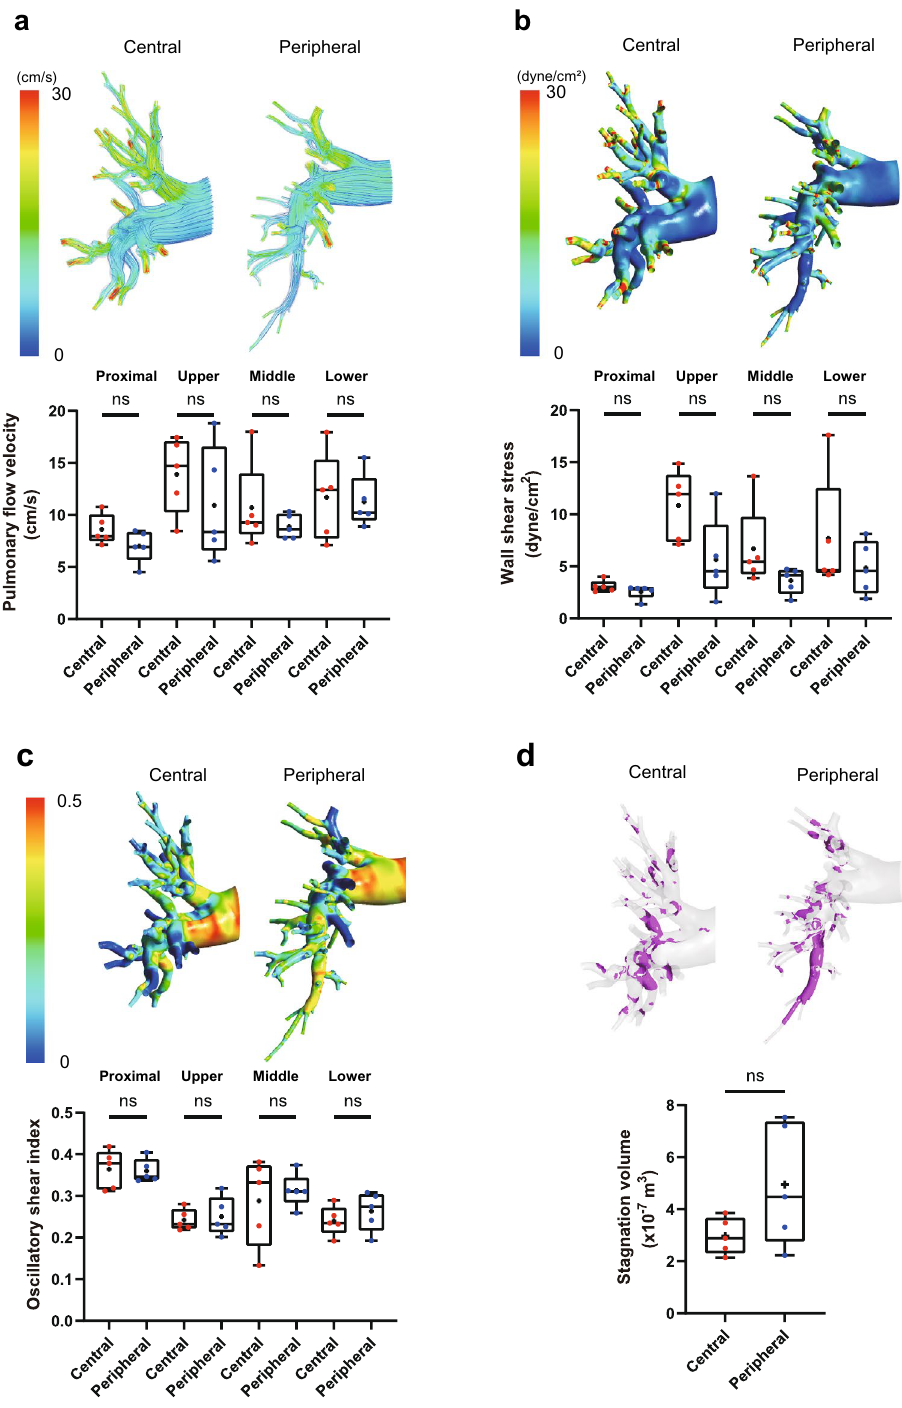
Figure 3. Comparison of pulmonary blood flow dynamics between central and peripheral type CTEPH. Pulmonary flow velocity ( a ), wall shear stress ( b ), oscillatory shear index ( c ), and blood stagnation volume ( d ) were simulated by CFD in the pulmonary arteries of patients with CTEPH in comparison with the central and peripheral types. Stagnation was defined as flow velocity of < 0.01 m/s. Data are presented as median (interquartile range). Cross indicates mean. The numbers in each box plot indicate the sample size for each group. ns, not